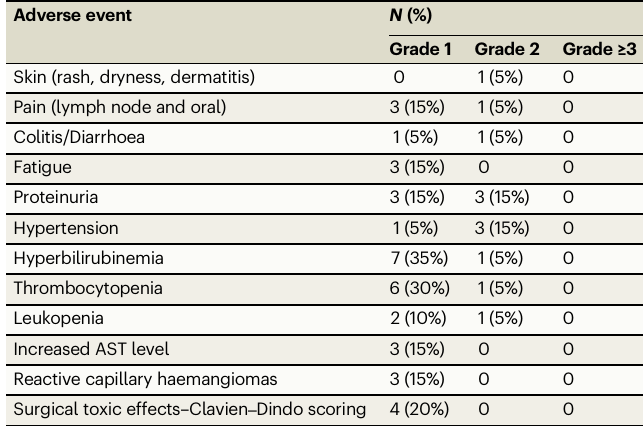
Table 2 | Neoadjuvant therapy-related adverse events (Com- mon Terminology Criteria for Adverse Events Version 5.0) and surgical-related adverse events (Clavien ‒ Dindo) in the 20 patients